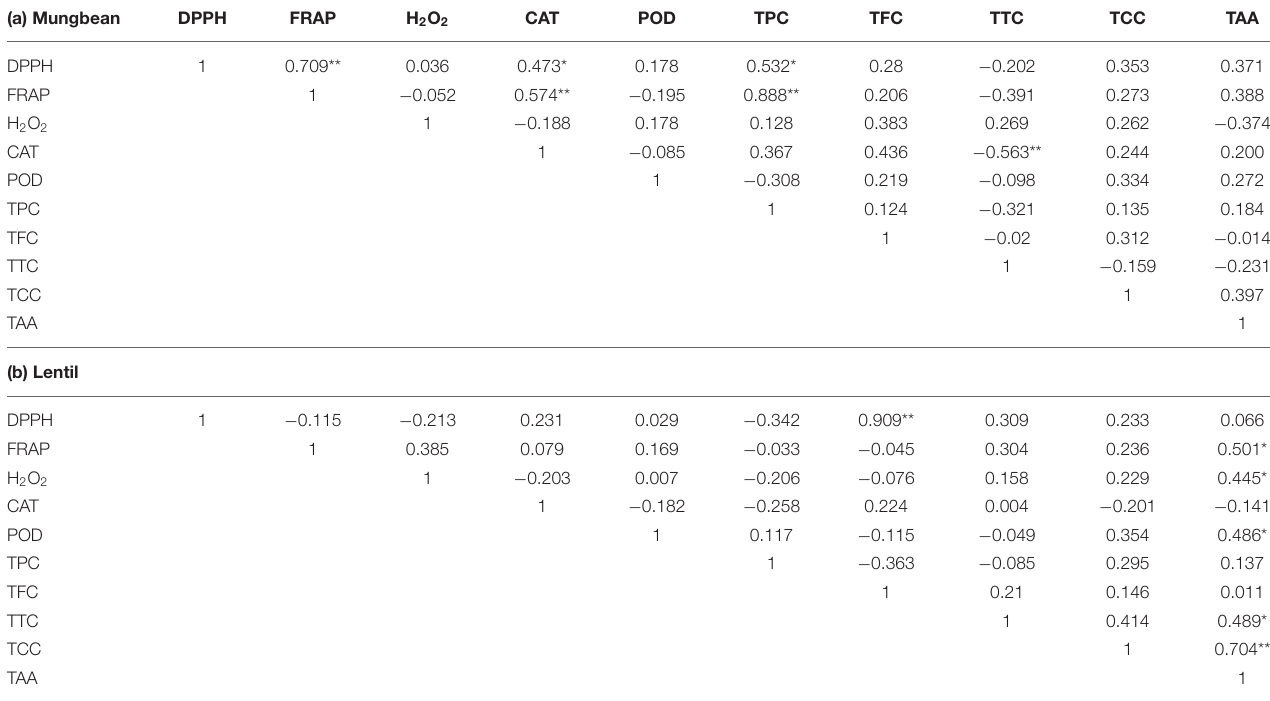
TABLE 5 | Correlation between various antioxidant and enzymatic parameters in (a) Mungbean and (b) Lentil